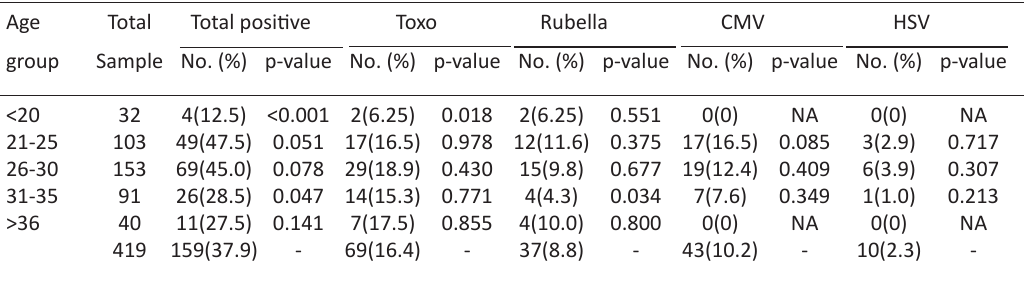
Table 3. Contribution of TORCH pathogens to age wise seropositivity in different groups of pregnant